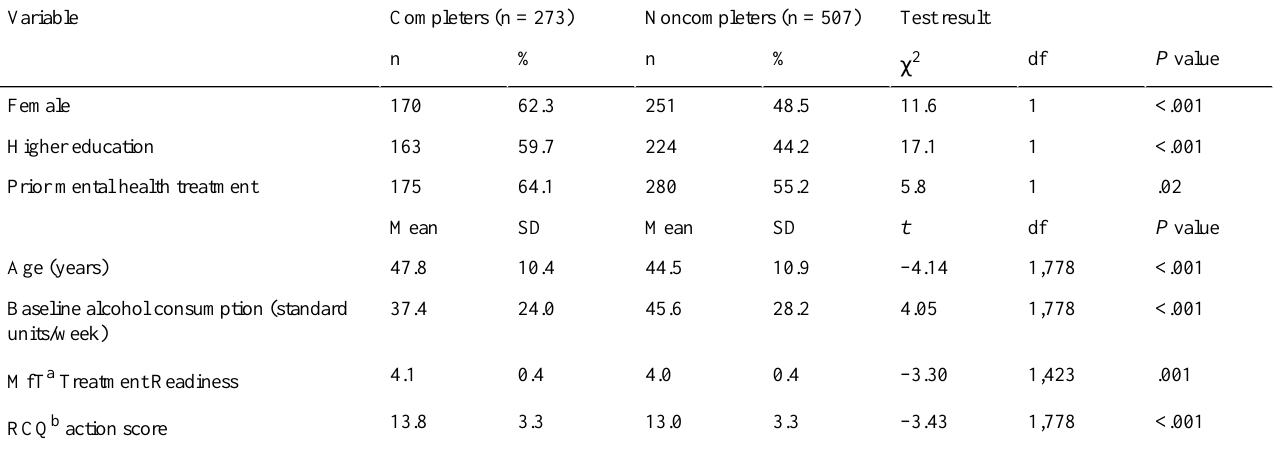
Table 2. Differences between open-access completers and noncompleters